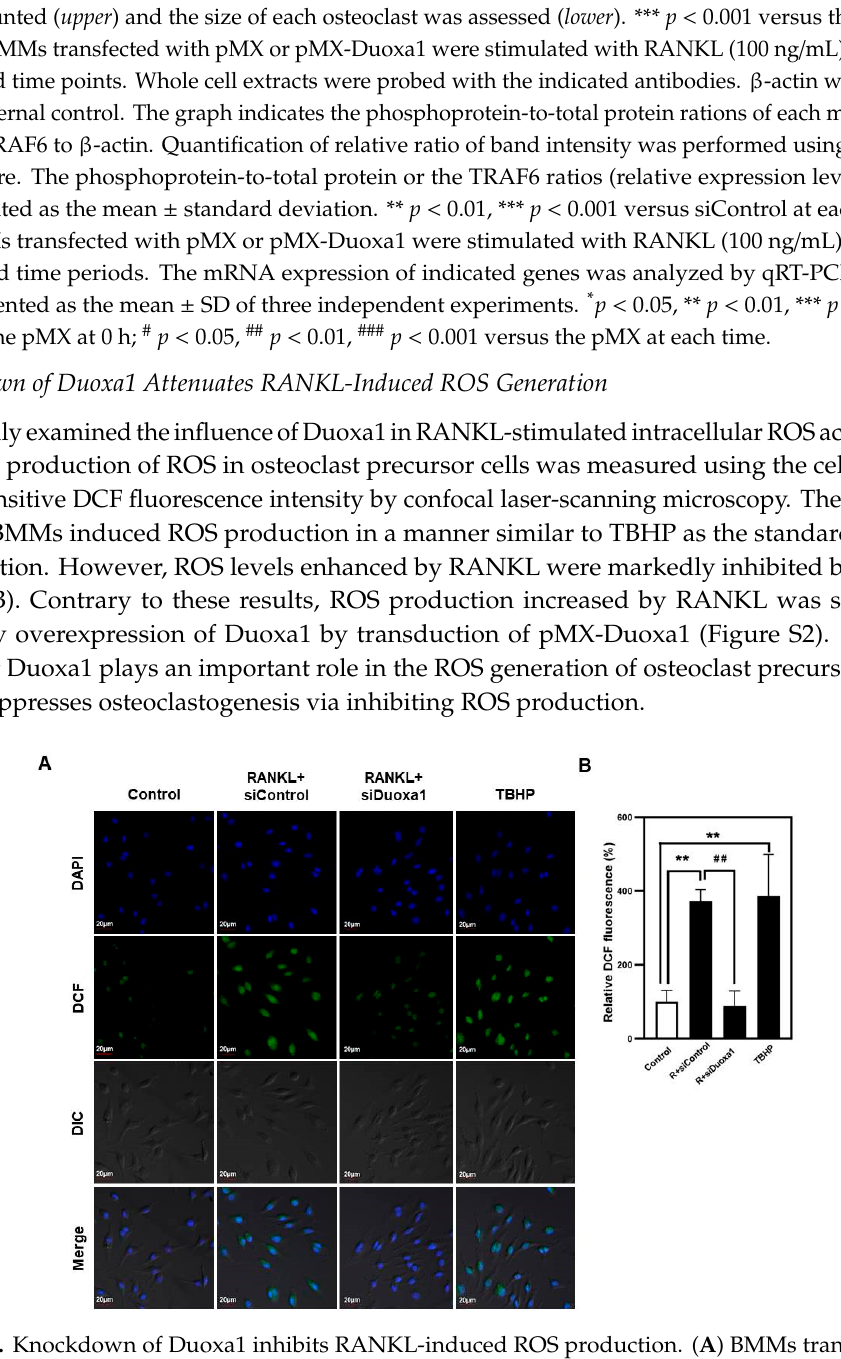
Figure 4. Knockdown of Duoxa1 inhibits RANKL-induced ROS production. ( A ) BMMs transfected with siControl or siDuoxa1 were treated with RANKL for 10 min, and ROS levels were determined by DCF fluorescence detection using a confocal laser-scanning microscope ( × 20). ( B ) The DCF fluorescence intensity was confirmed for the region of interest (ROI). Results are representative of at least 3 independent sets of similar experiments. TBHP was used as the standard control for ROS production. Data are presented as the mean ± SD of three independent experiments. ** p < 0.01 versus the negative siControl. ## p < 0.01 versus the positive siControl.